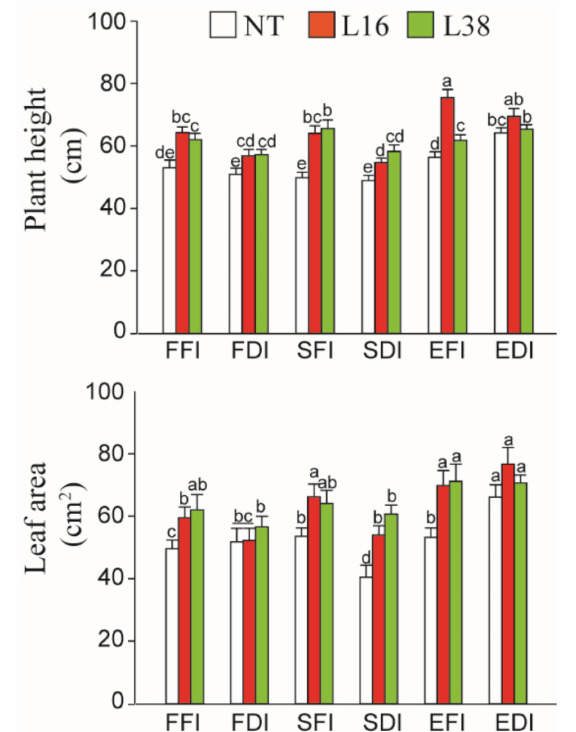
Figure 3. Plant height and leaf area for each irrigation treatment in 2016, 2017, and 2018 (Supplemen- tary Table S3) with mixed model analysis. Full forecast irrigation (FFI); 75% of full forecast irrigation (FDI); full soil moisture irrigation (SFI); 75% of full soil moisture irrigation (SDI); full flood irrigation (EFI); 75% of full flood irrigation (EDI). Different letters indicate significant differences between transgenic lines and NT following Duncan’s multiple range tests at the 5% level of